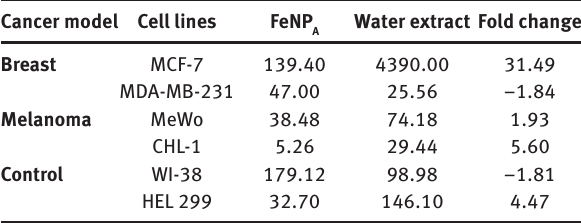
and ASP in cell lines (µg/mL). A